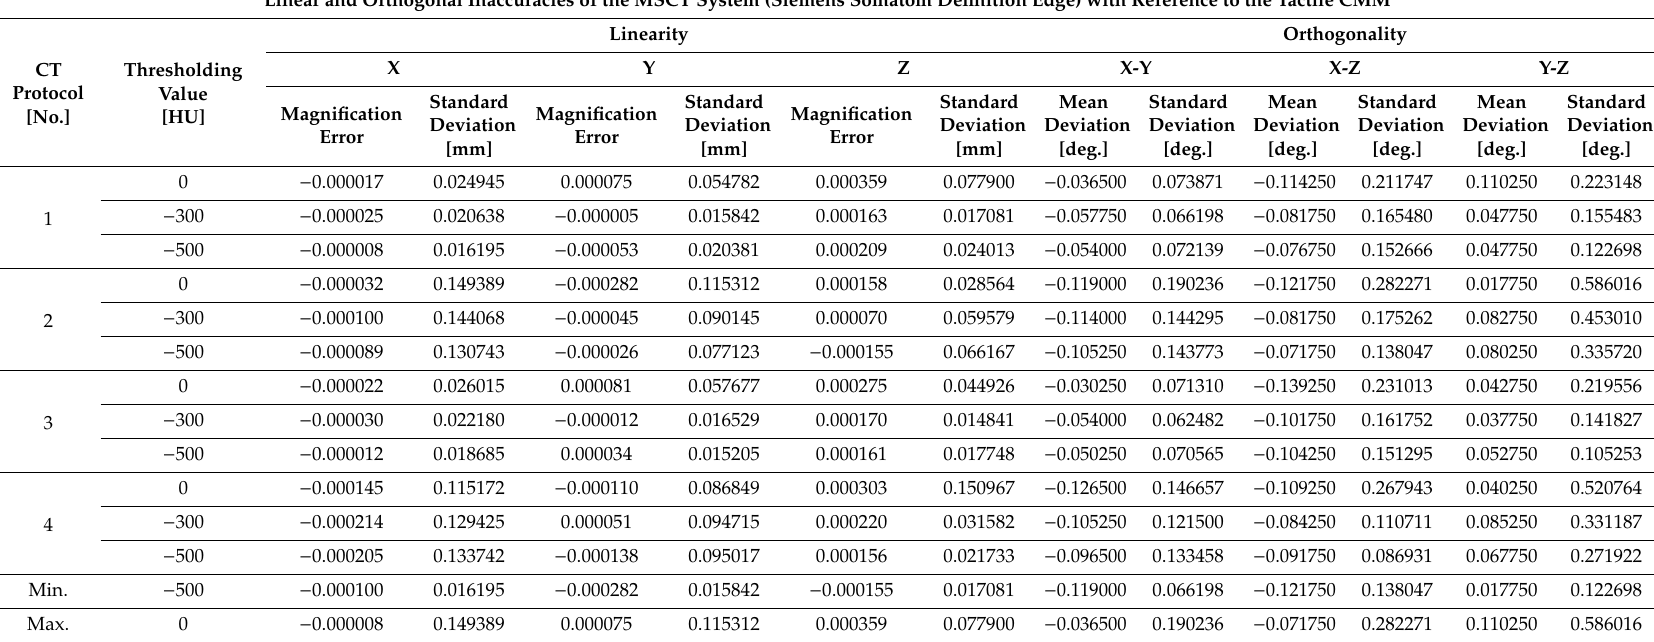
Table 4. Linear and orthogonal inaccuracies of the MSCT